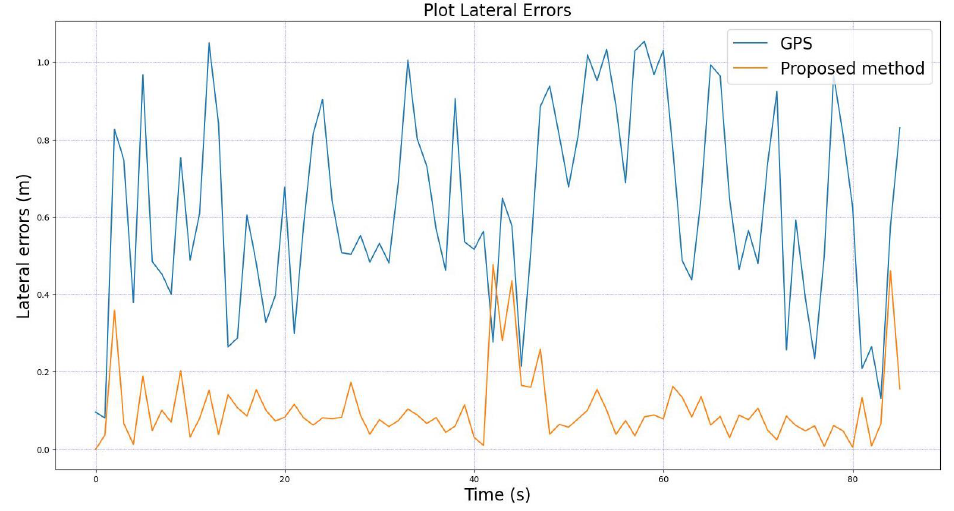
Figure 12. Comparison of lateral errors between the GPS and the proposed